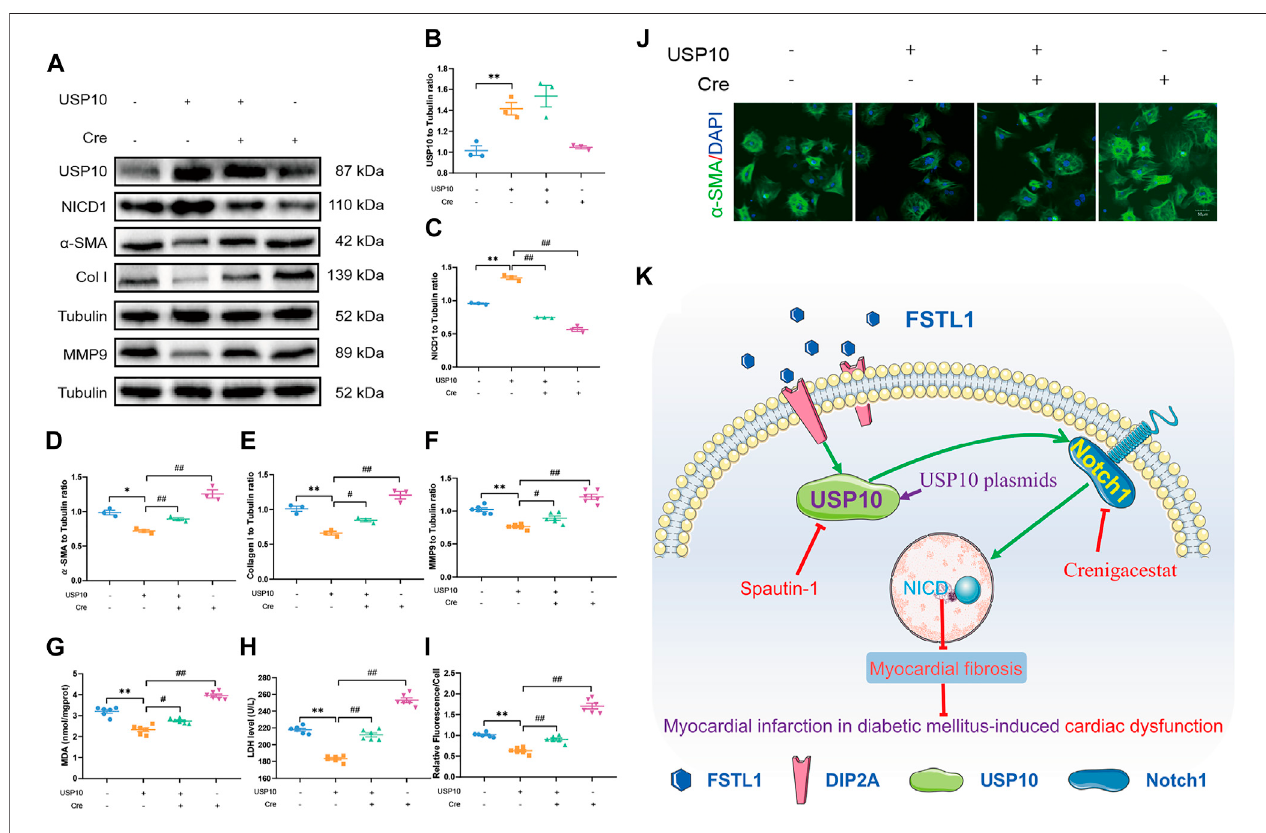
FIGURE7| Levels ofUPS10,NICD1 and myocardial fi brosisrelatedproteins inCFsisolated fromT2DM mice post-notch1inhibition. (A) Representativeimages of Western blot in CFs with USP10 treatment; (B) USP10 level; (C) NICD1 level; (D) α -SMA level; (E) Collagen I level; (F) MMP9 level; (G) MDA content; (H) LDH level; (I) Quanti fi cation of α -SMA staining. (J) Immuno fl uorescence staining of α -SMA; nuclei are marked by Hoechst 33342 staining; scale bar (cid:2) 50 μ m; Green fl uorescence represents α -SMApositivenuclei;DAPI:blue fl uorescencerepresentstotalCFsnuclei;andK:FSTL1-USP10-notch1signalingaxisplaysacriticalroleinattenuating myocardial infarction by inhibition myocardial fi brosis in diabetic mice. The results are presented as Mean ± SEM, n (cid:2) 3 – 6 in each group. ** p < 0.01.